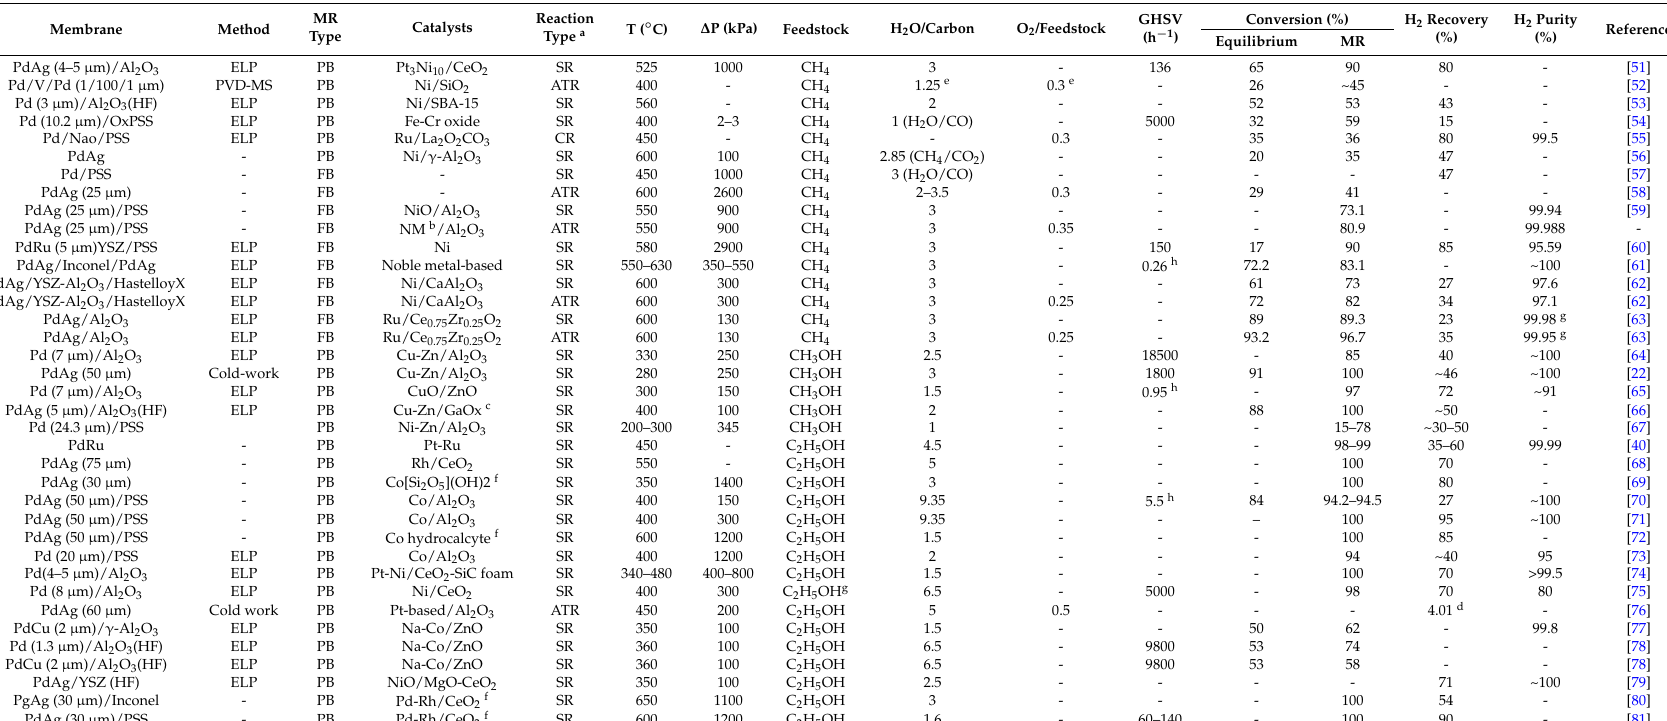
Table 2. Performance and operating conditions of several membrane reactors for reforming of methane, methanol and ethanol, reported in the last years.